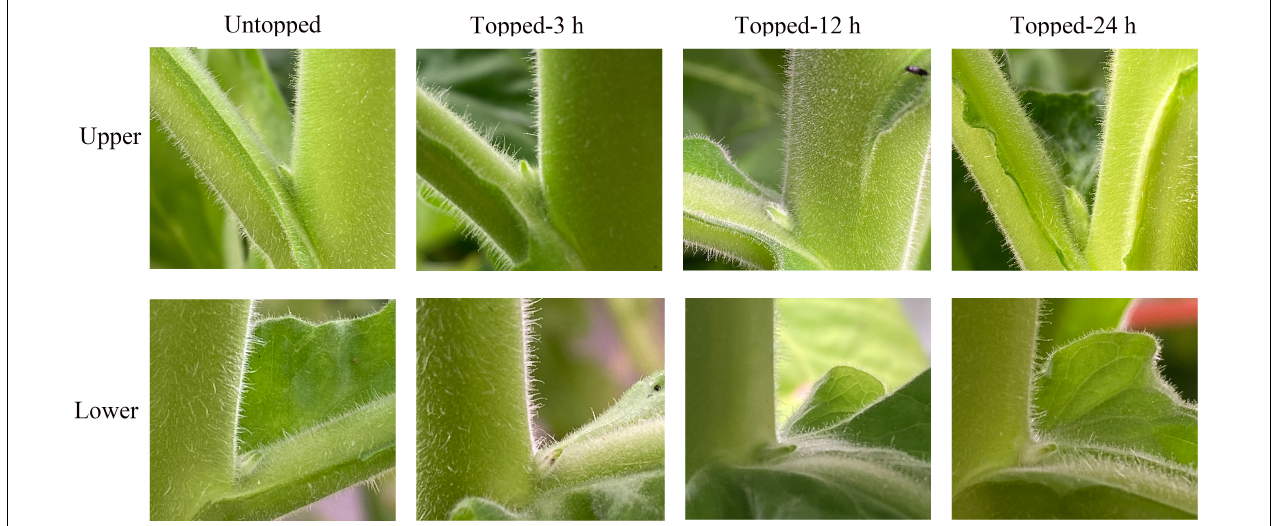
FIGURE 1 | Upper and lower axillary buds development and phenotypes in untopped and topped tobacco plants. Upper axillary buds before topping (Cku), upper axillary buds at different time points after topping (3 h: 3 hu; 12 h: 12 hu; and 24 h: 24 hu), lower axillary buds before topping (Ckd), and lower axillary buds 3 h after topping (3